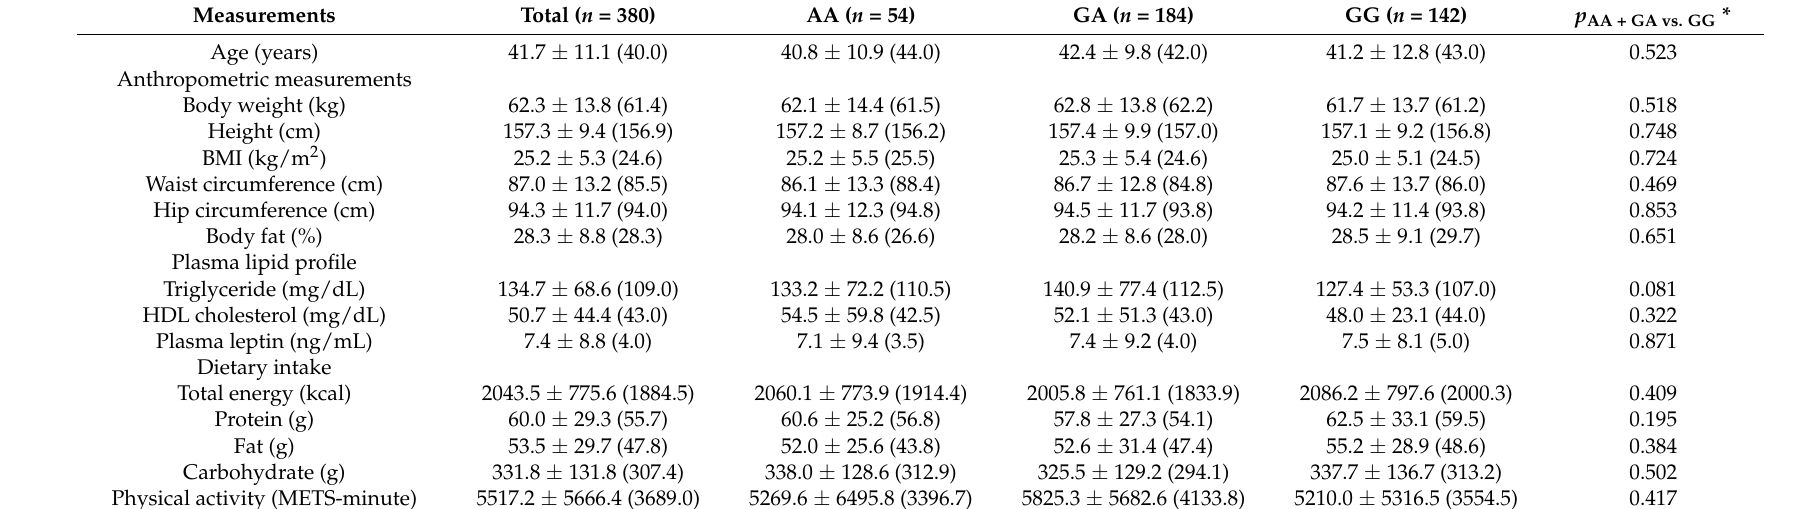
Table 1. Anthropometric, biochemical and lifestyle variation between